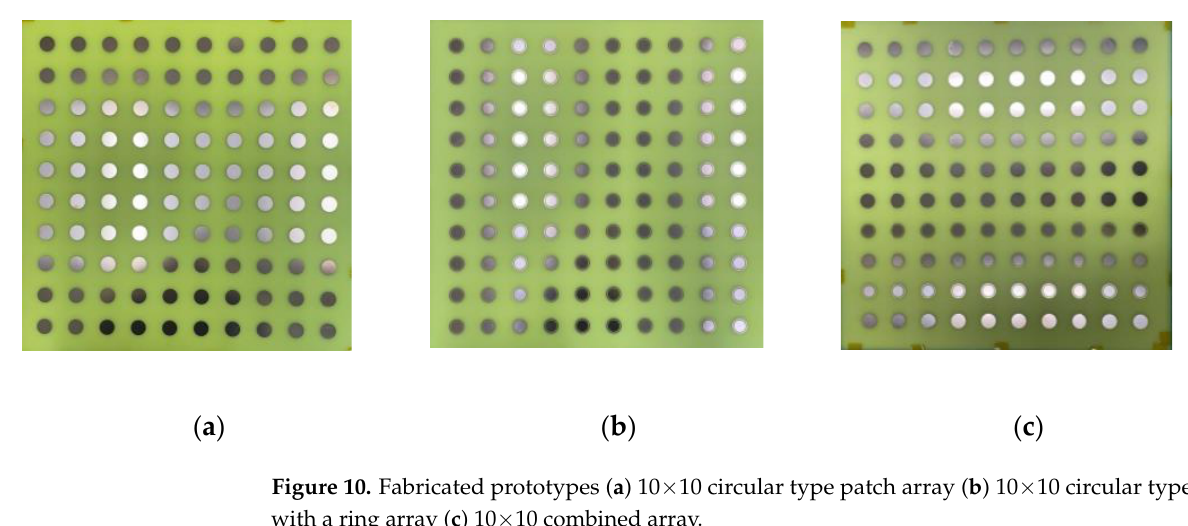
Figure 10. Fabricated prototypes ( a ) 10 × 10 circular type patch array ( b ) 10 × 10 circular type patch with a ring array ( c ) 10 × 10 combined array.